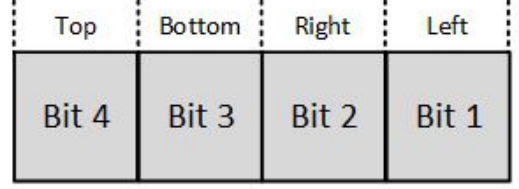
Figure 3. Cohen–Sutherland endpoint region code.